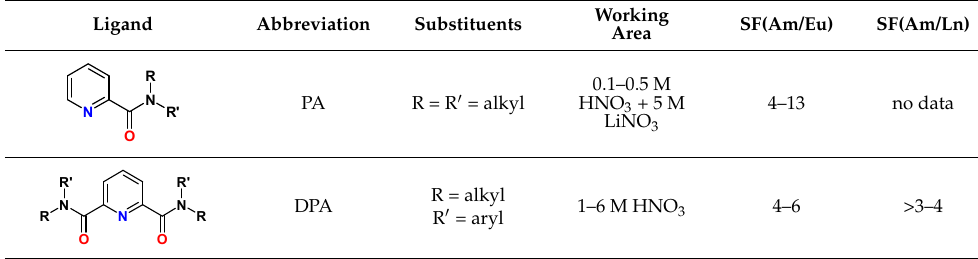
Table 4. The comparative data on selectivity of americium extraction over europium and lantha- nides.